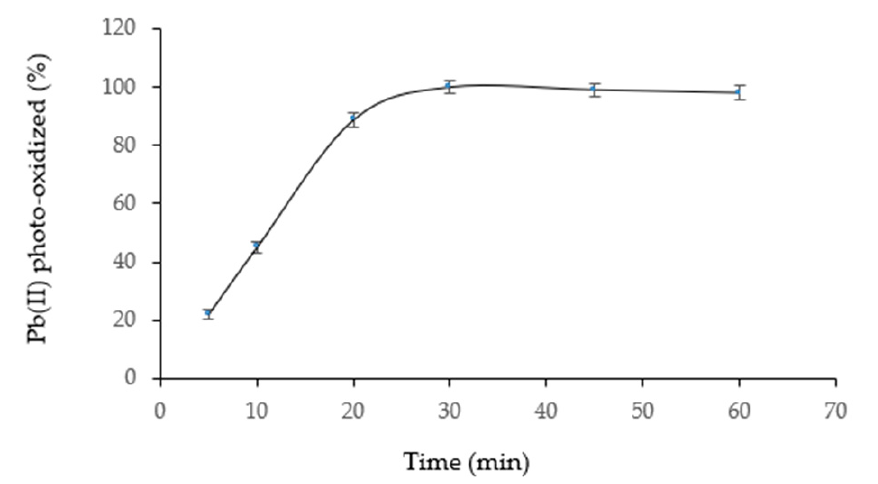
Figure 6. The influence of the irradiation time on the Pb(II) photo-oxidation (photocatalyst weight = 15 mg, volume of Pb(II) solution = 25 mL, Pb(II) concentration = 15 mg/L, and solution pH = 7).